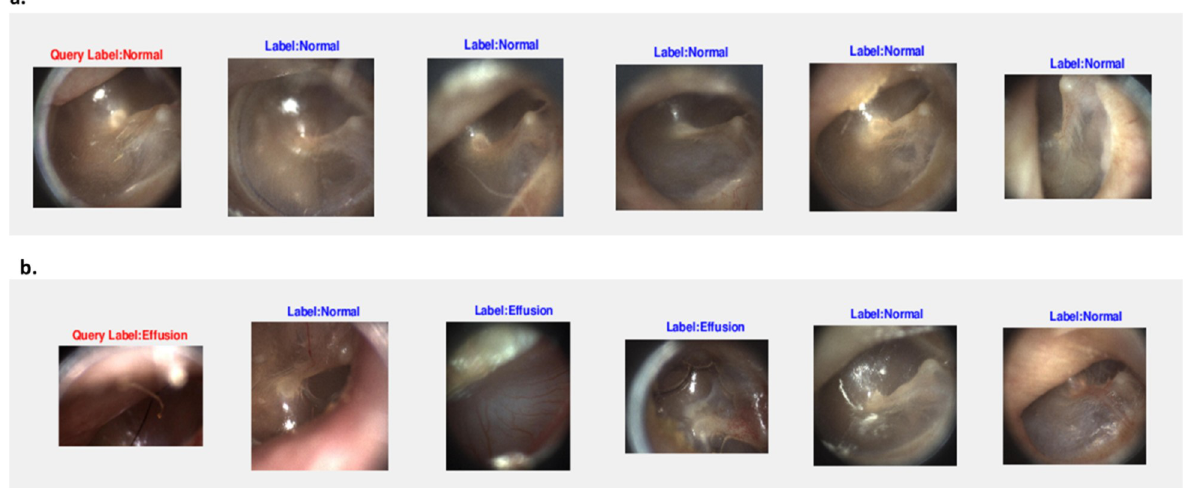
Fig 8. Effect of quality of the query image. a. For a clear and well-focused query image, the image retrieval accuracy is 100% for five retrieved images selected with the Cosine similarity metric. b. For an out-of-focus query image, the image retrieval accuracy is 40% for five retrieved images selected with the Cosine similarity